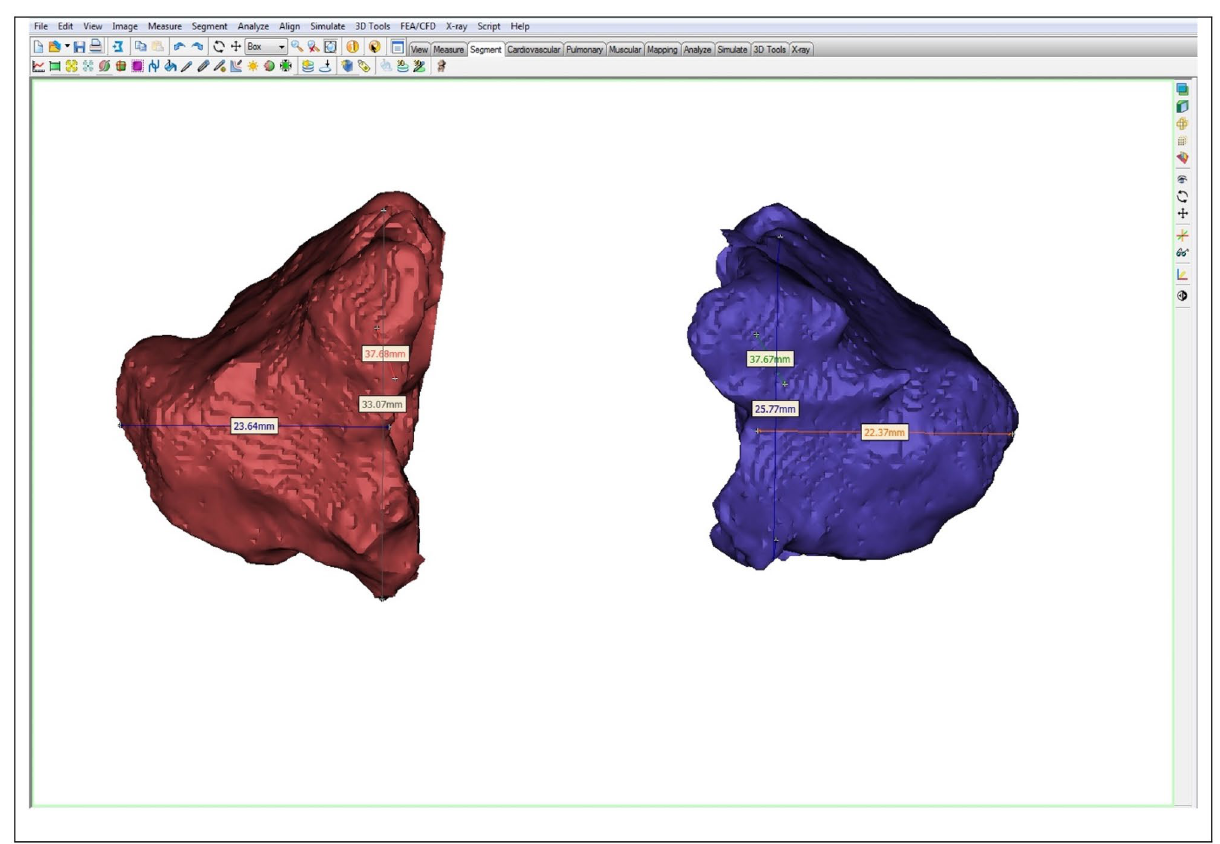
Figure 3. Measurements of the MSs automatically generated by Mimics Research™ v.16 software (NV, Technologielaan 15, 3001 Leuven, Belgium, https:// www. mater ialise. com/ en/ medic al/ mimics- innov ation- suite/